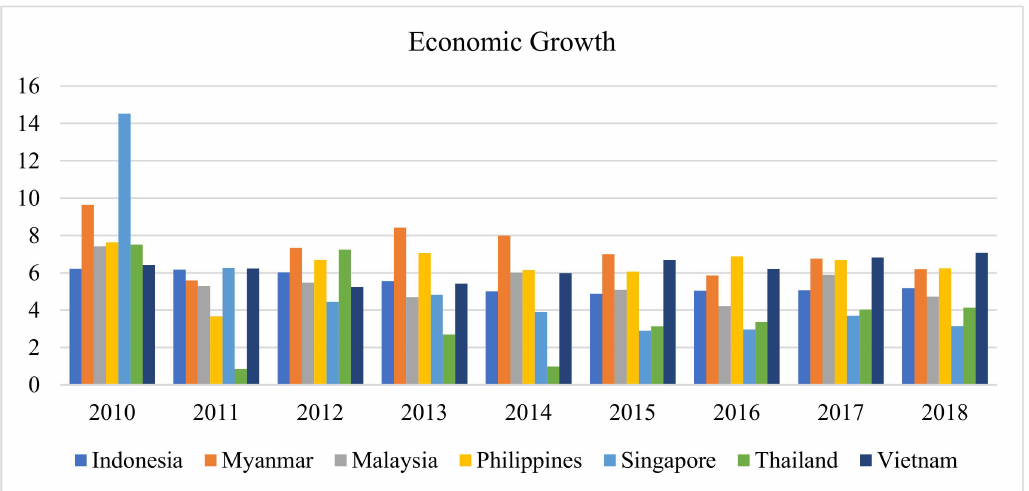
Figure 1. Top ASEAN countries’ economic